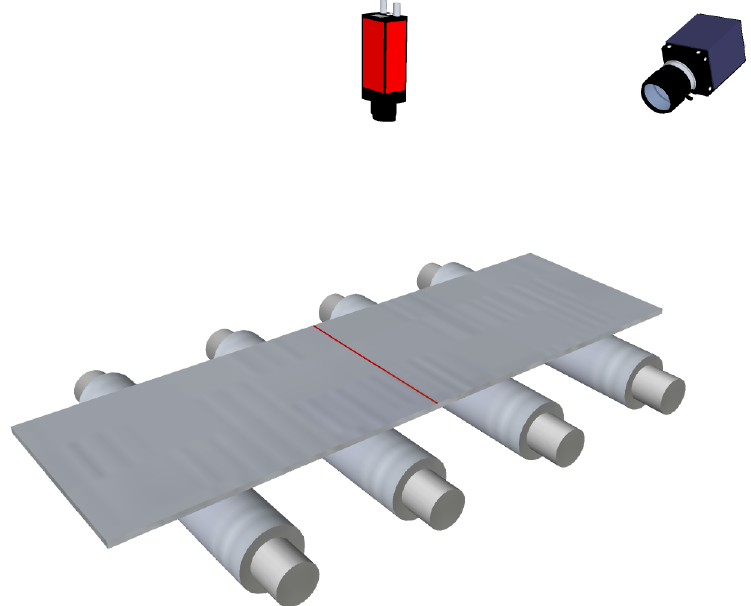
Figure 8. Flatness sensor based on active optical triangulation. A laser stripe is projected across the width of the rolled product and is imaged using a matrix camera.